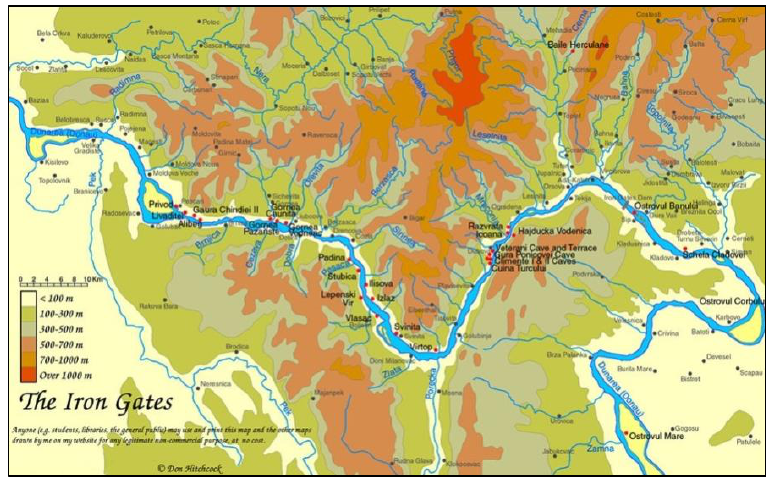
Figure 11. Places of Culture of Lepenski